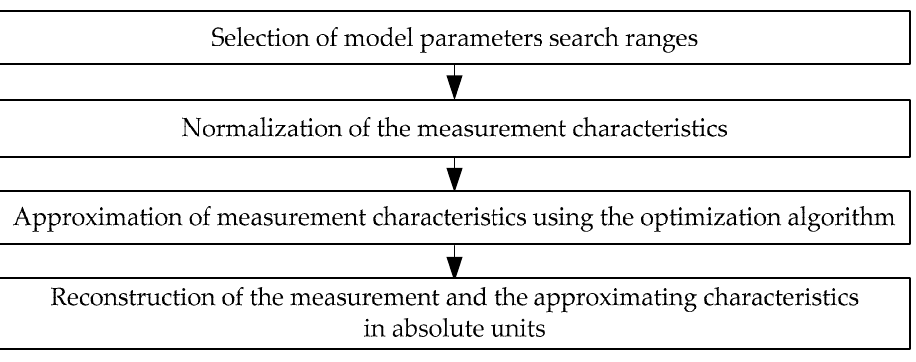
Figure 4. A system flow diagram showing the described calculation method.